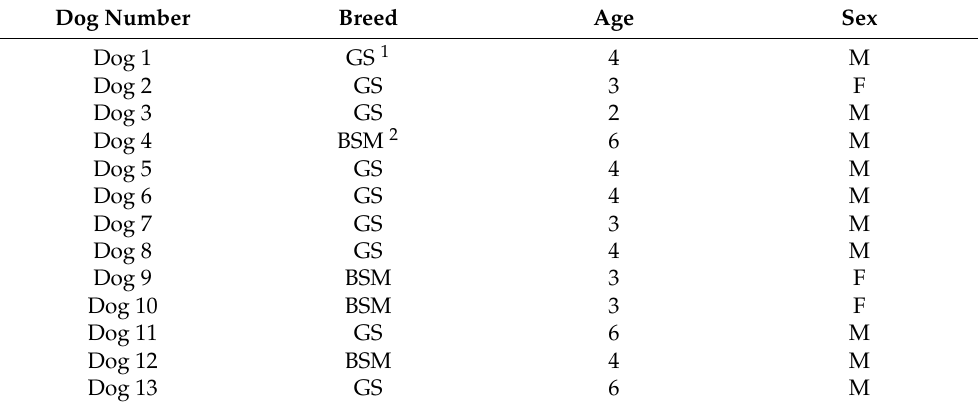
Table 1. Information on study population.